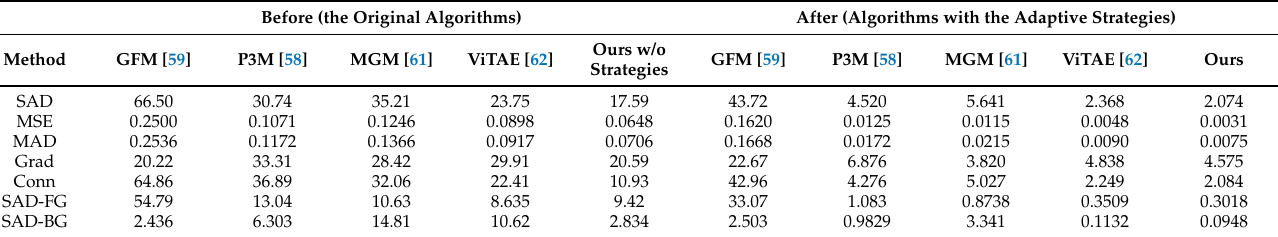
Table 5. Comparison results with adaptive strategies.